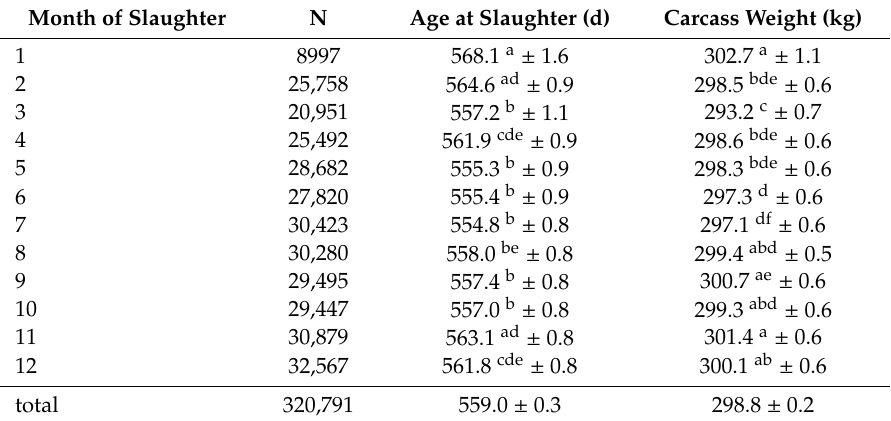
Table 4. Number of beef carcasses per month, means ± std. error for the age at slaughter (days, d) and carcass weight (kg).